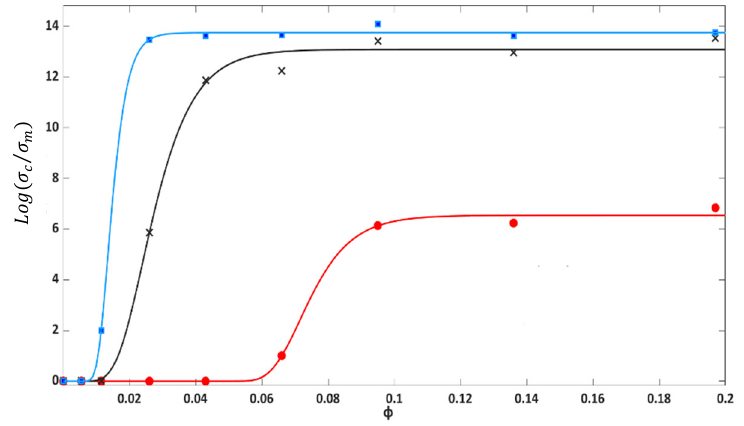
Figure 9. Relative electrical conductivity ( σ c ) of Cu-PU composites under pressure: 1 kPa (red), 4 kPa (black) and 20 kPa (blue). The symbols represent the experimental conductivity and curves are the values from Equation (3) using the parameters of Table 3. Table 3. The values of adjustable parameters, B , α , n of Equation (3), 𝜙 , calculated percolation 𝑐 threshold concentration from Equation (4) in volume fraction and vol.% and σ c,max is the calculated maximum of conductivity. P is the pressure and s is the standard deviation of model.